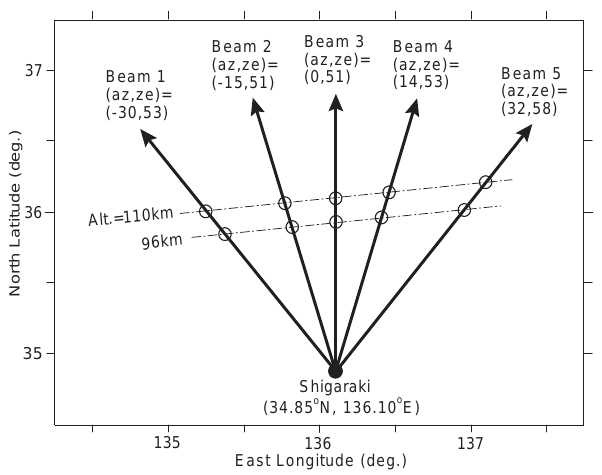
Fig. 1. Bearings (azimuth and zenith) of 5MU radar beams on geographic coordinates. Points where the beams penetrate 96 and 110km altitudes are indicated by white